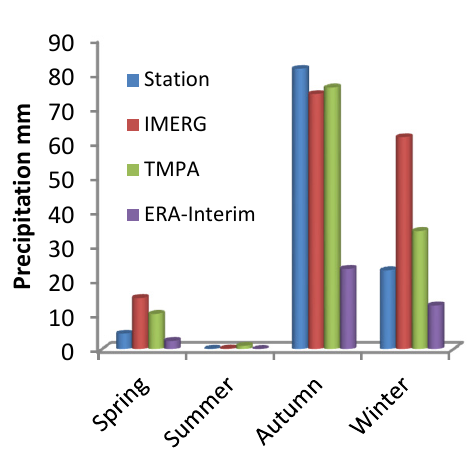
Figure 13. Bushehr seasonal